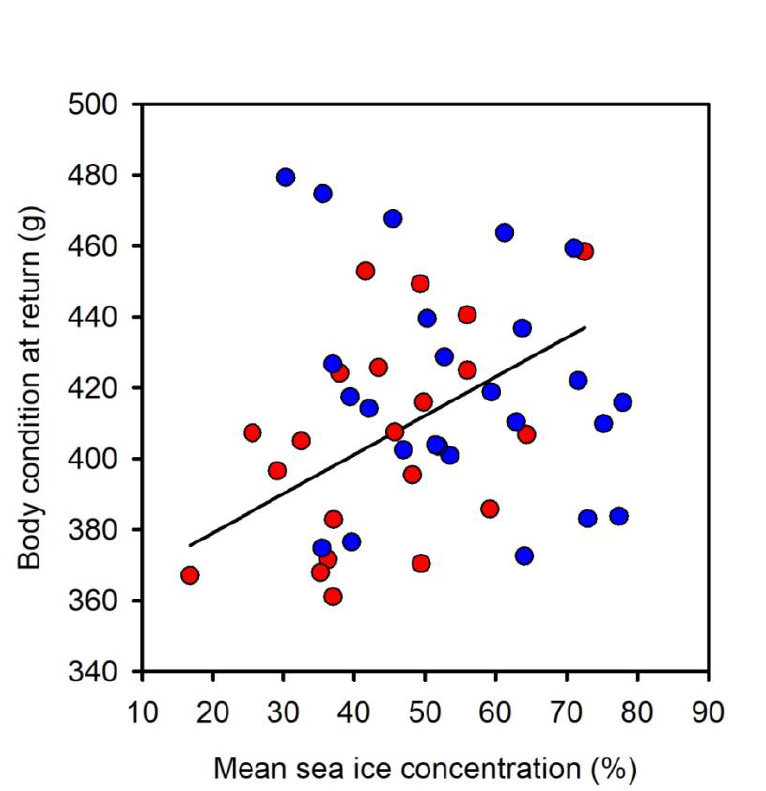
Figure 8. Body condition at return from a foraging trip as a function of the mean sea ice concentration of the foraging trip locations for male (blue) and female (red and solid line) snow petrels sampled at Ile des Pétrels, Adélie Land, East Antarctica. For females: F 1,19 =6.106, P=0.023, R² =